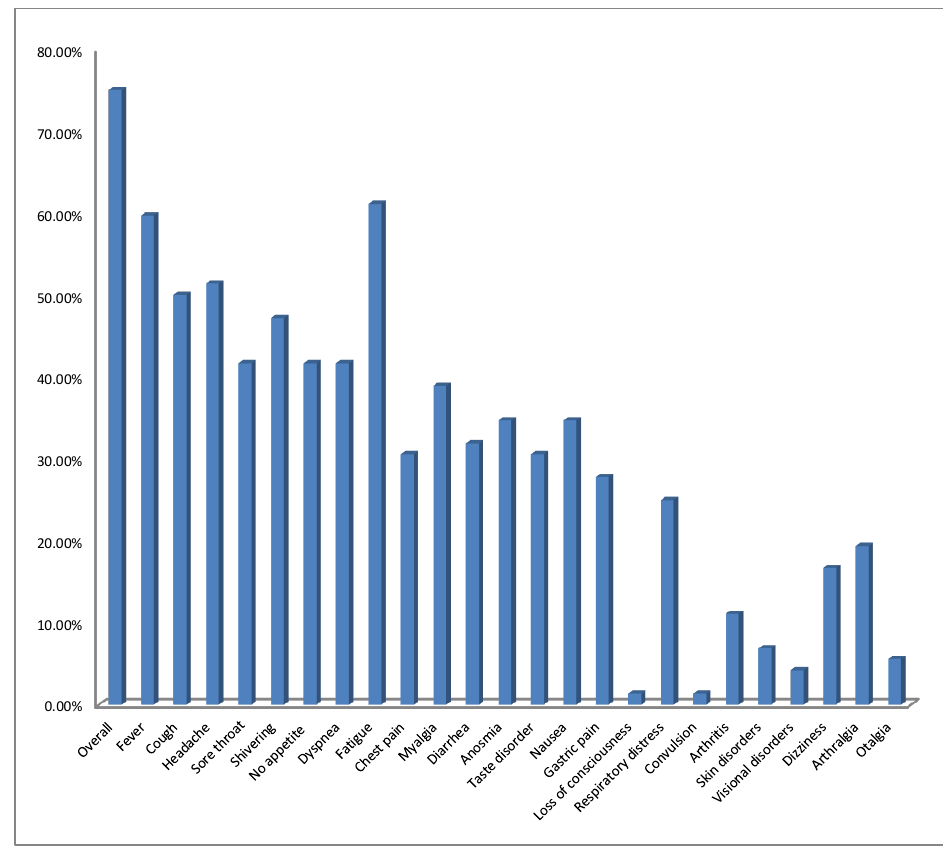
Figure 1 : Clinical manifestation in Covid-19